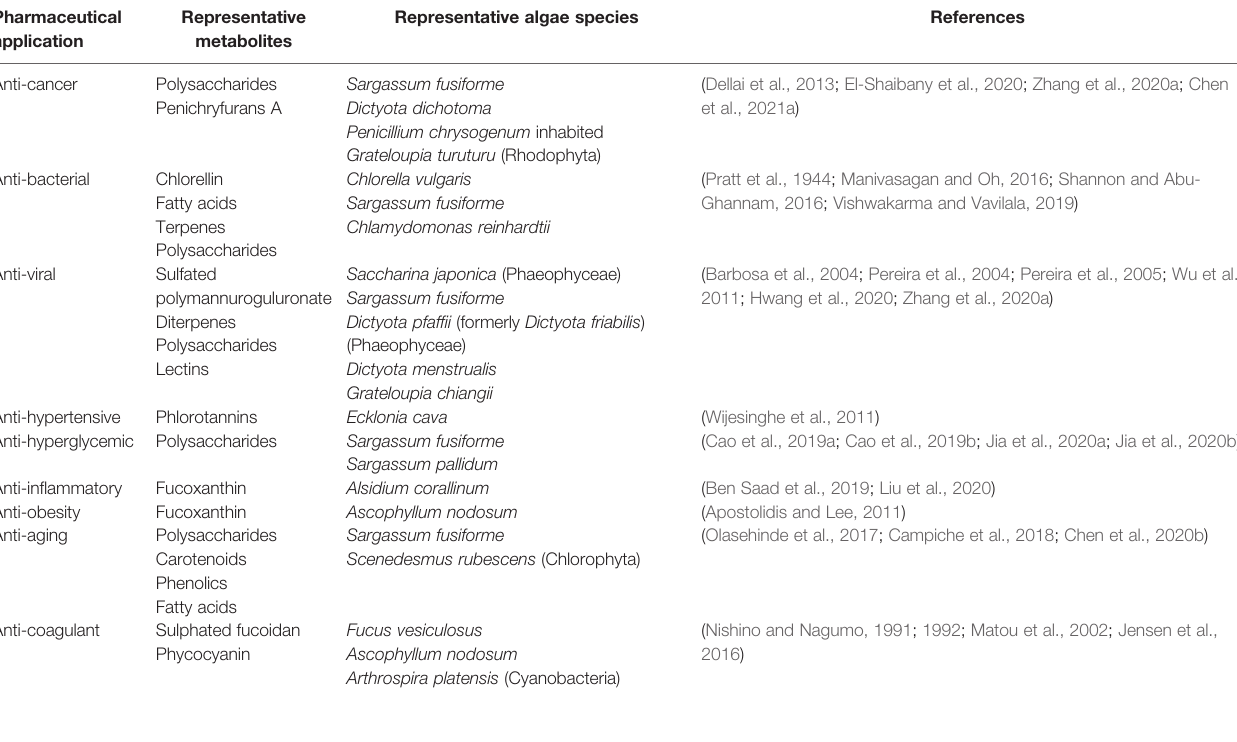
TABLE 1 | The main algal pharmaceutical